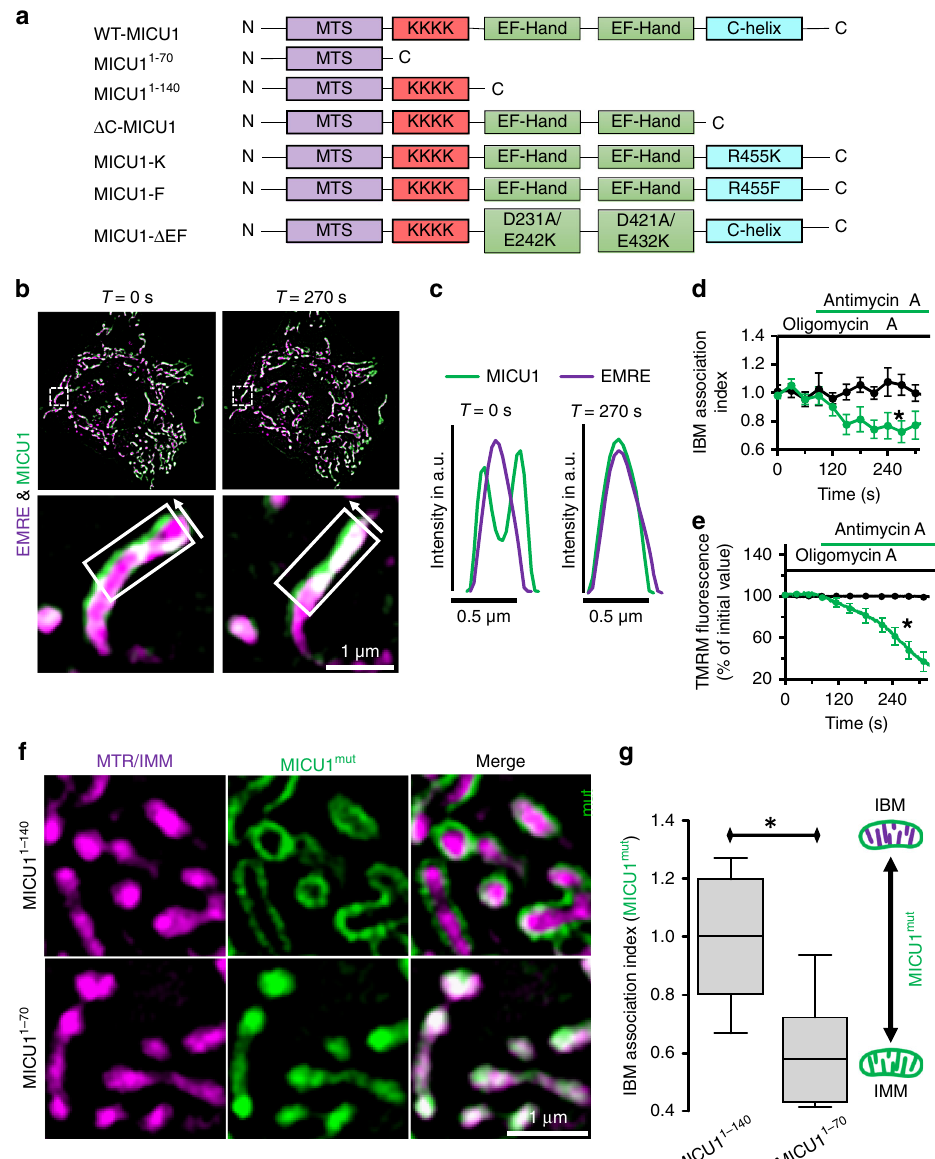
Fig. 2 ψ mito and the poly-lysine domain of MICU1 are required for IBM localization. a Schematic representation of MICU1 mutants used in this work. (MTS → mitochondrial targeting sequence; KKKK → poly-lysine domain; EF-Hand → Ca 2 + binding domain; C-Helix → C-terminal hexamerization domain). b Representative images of SIM time-lapse experiment using HeLa cells transiently transfected with MICU1-YFP (green) and EMRE-mCherry (magenta) after T = 0 and T = 270 s. Cells were pre-incubated with oligomycin A (2 µ M) and antimycin A (4 µ M) was added at T = 90 s. c Line plots of MICU1 (green line) and EMRE (magenta line) of regions in between the white arrows in b con fi rm the redistribution of MICU1 into the IMM after addition of antimycin A. Differences between oligomycin A and oligomycin A plus antimycin A traces were measured from T = 50 s. d Time course of the MICU1 IBM association index over time after pre-incubation with oligomycin A with (green) or without (black) exposure to antimycin A starting at T = 90 s ( n Control = 7; n = 9. Data are shown as the mean ± SEM. e Corresponding tetramethylrhodamine methyl ester perchlorate (TMRM) fl uorescence, which Oligomycin/Antimycin indicates ψ mito . Cells were pre-incubated with oligomycin A and exposed to antimycin A (green) or DMSO (black) at T = 90 s ( n Antimycin = 8; n Antimycin/ = 9). A signi fi cant drop in ψ mito after addition of antimycin A correlates with the drop in MICU1 IBM association index. Data are shown as the Oligomycin mean ± SEM. f Representative dual-SIM images of HeLa cells stained with MTR (magenta) and expressing MICU1 1 – 140 -cpEGFP (green, upper panel) or MICU1 1 – 70 -cpEGFP (green, lower panel). g Respective statistical analyses of the IBM association index of MICU1 1 – 140 and MICU1 1 – 70 . The sub- mitochondrial distribution of MICU1 1 – 140 and MICU1 1 – 70 in the IBM and the CM was determined with the IBM association index. Horizontal lines represent the median, the lower and upper hinge show respectively fi rst quartile and third quartile, and lower and upper whisker encompass minimal and maximal values. Images and analyses were obtained from n = 9 independent experiments, which assessed a total of 45 cells. * P < 0.05 vs. respective control conditions carried out with unpaired double-sided T -test. Source data are provided as a Source Data fi